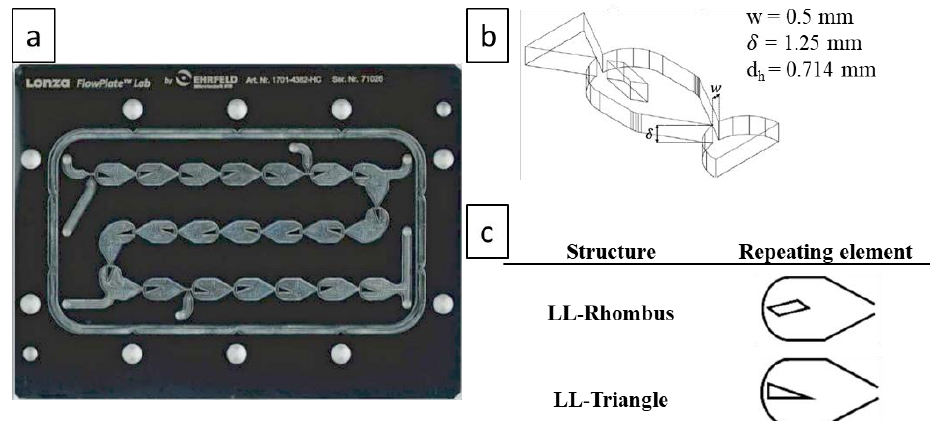
Figure 2. Geometry of FlowPlate TM and mixing